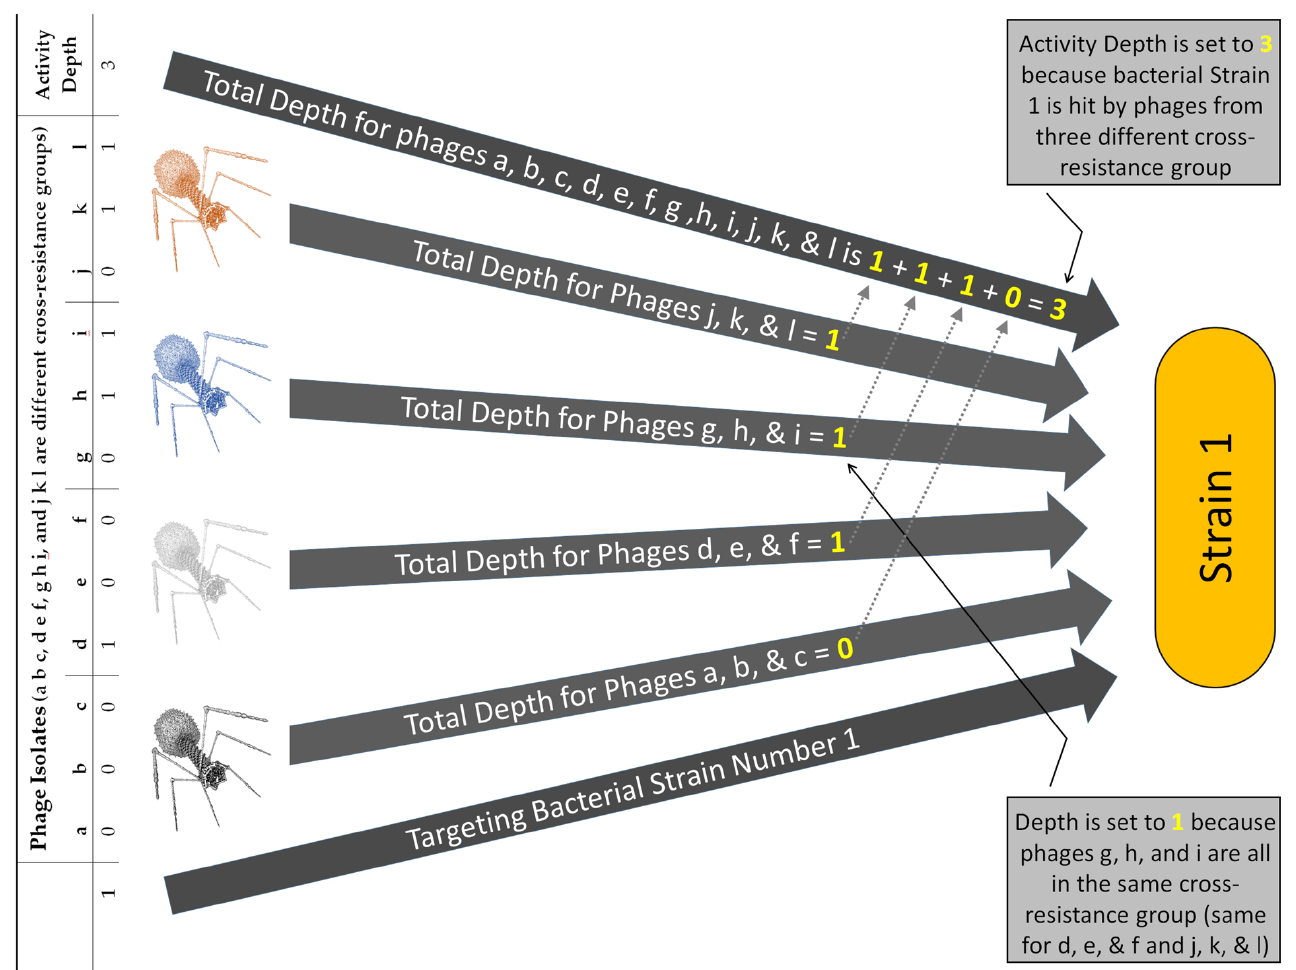
Figure 6. Example of calculation of activity depth taking into account multiple cross-resistance groups with diverse phage membership. Shown to the left are the first rows of Table S1, Supplementary Materials. The number “1” found in the lower, left-hand corner refers to bacterial strain number 1, as indicated within the lower arrow. Demonstrated also within the arrows (top) is how an activity breadth of 3 is arrived at for bacterial strain number 1. Note that the “Total depth” for each cross-resistance group cannot exceed a value of 1 and thus is equal to either 0 or 1.